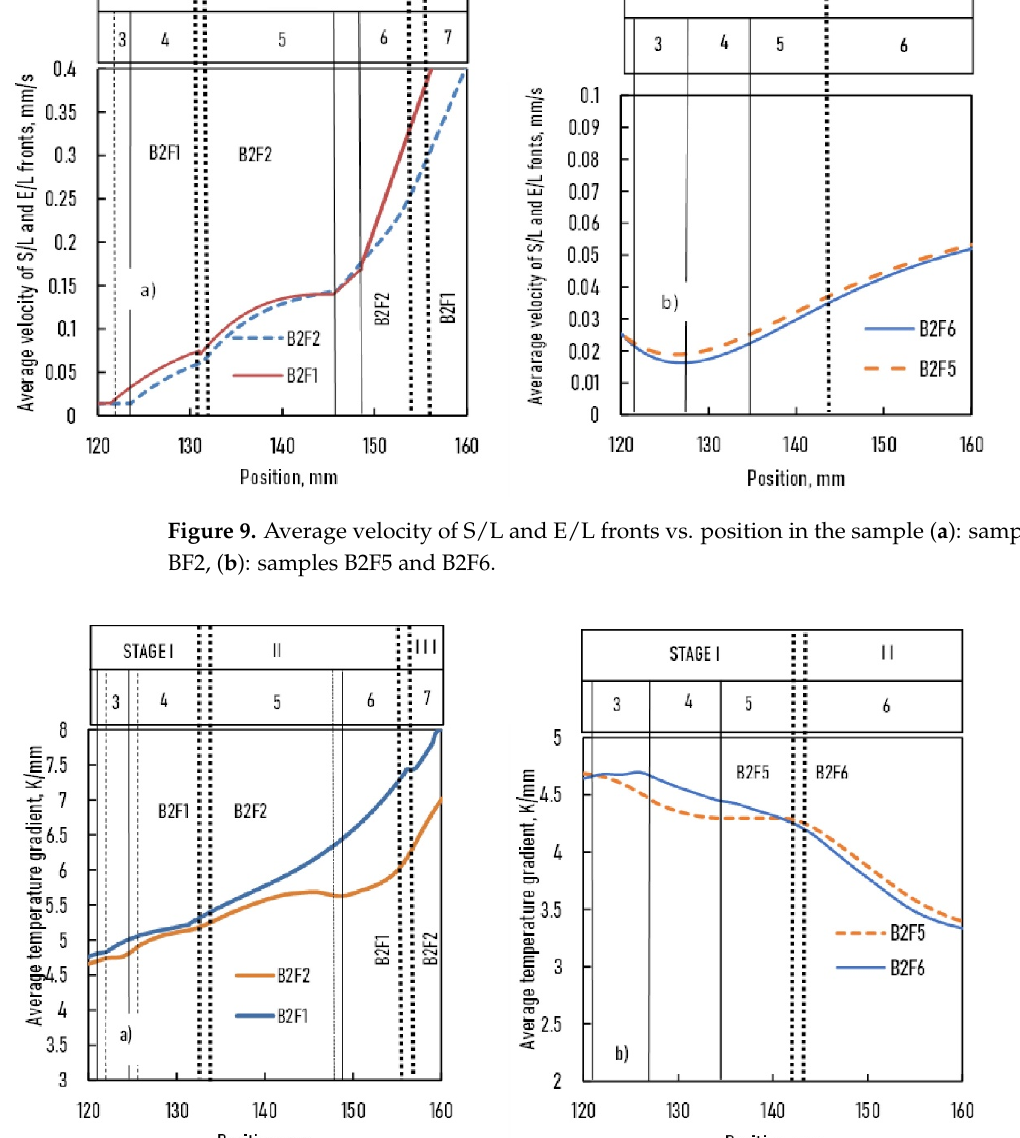
Figure 11 . Secondary dendrite arm spacing of B2F1 and B2F2 samples vs. position in the sample ( a ): samples B2F1 and BF2, ( b ): samples B2F5 and B2F6.